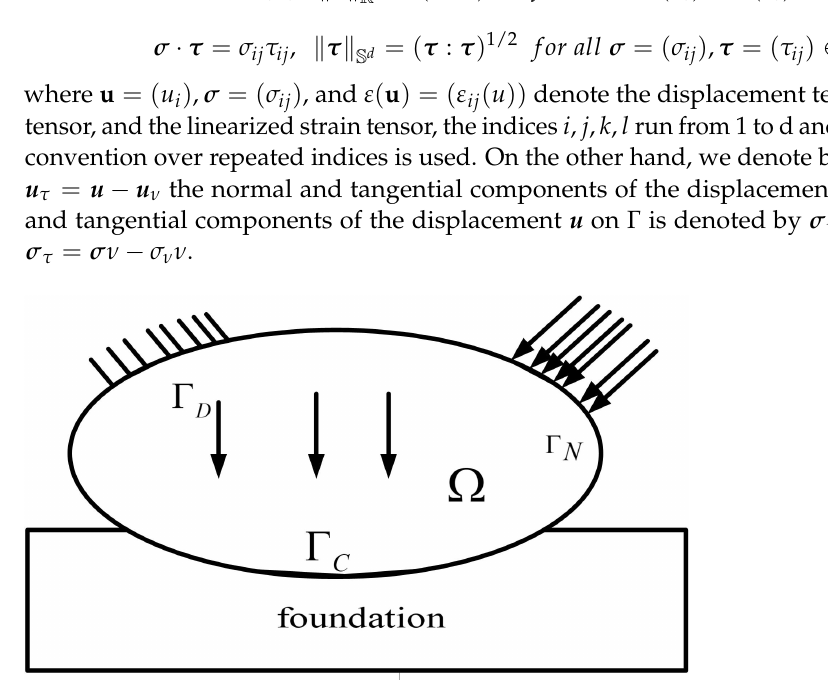
on surface traction Γ N . N